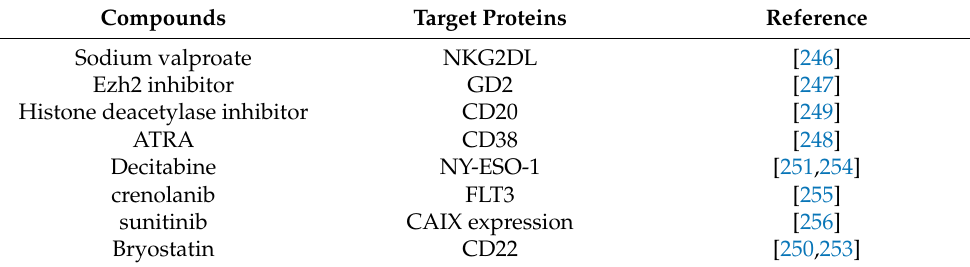
Table 4. Compounds upregulating specific